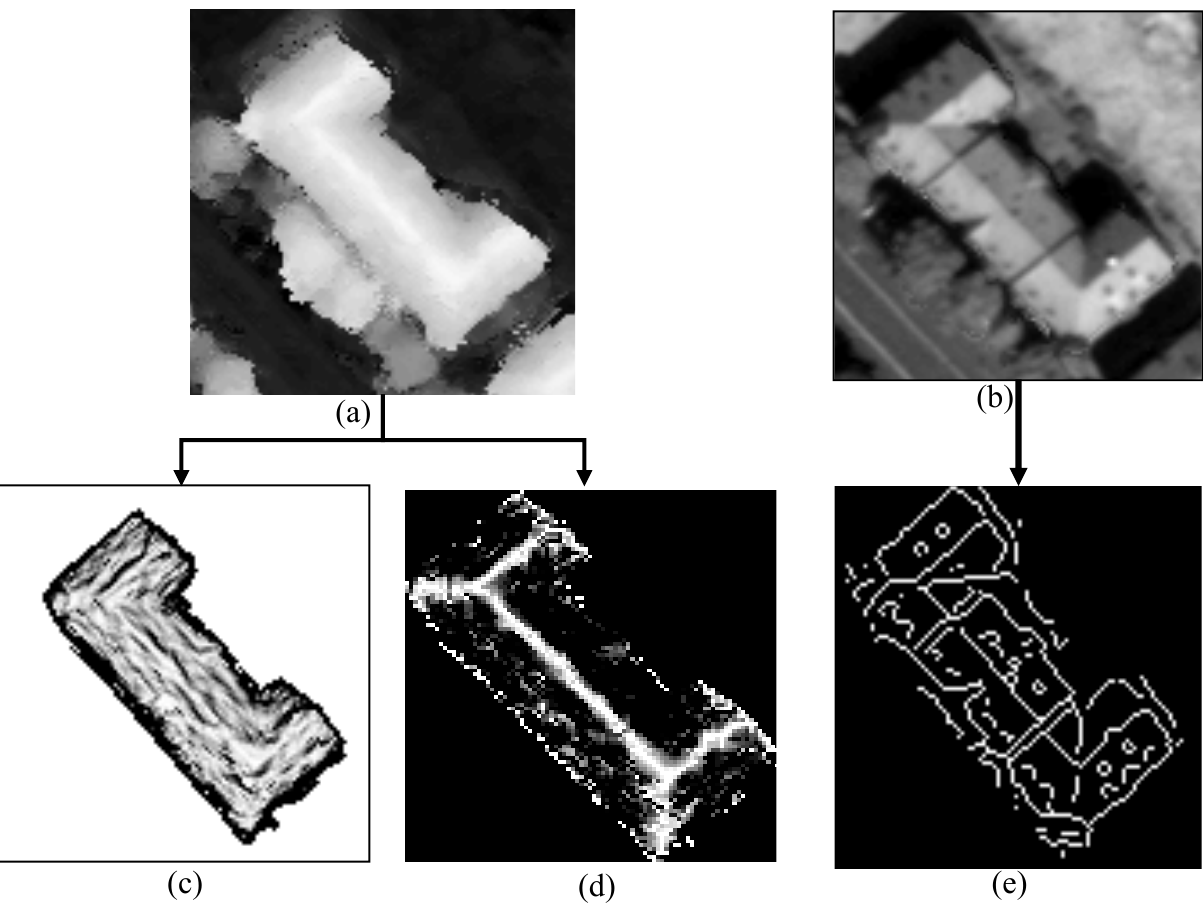
Figure 4. Feature extraction from DSM and orthorectified images. ( a ) Worldview